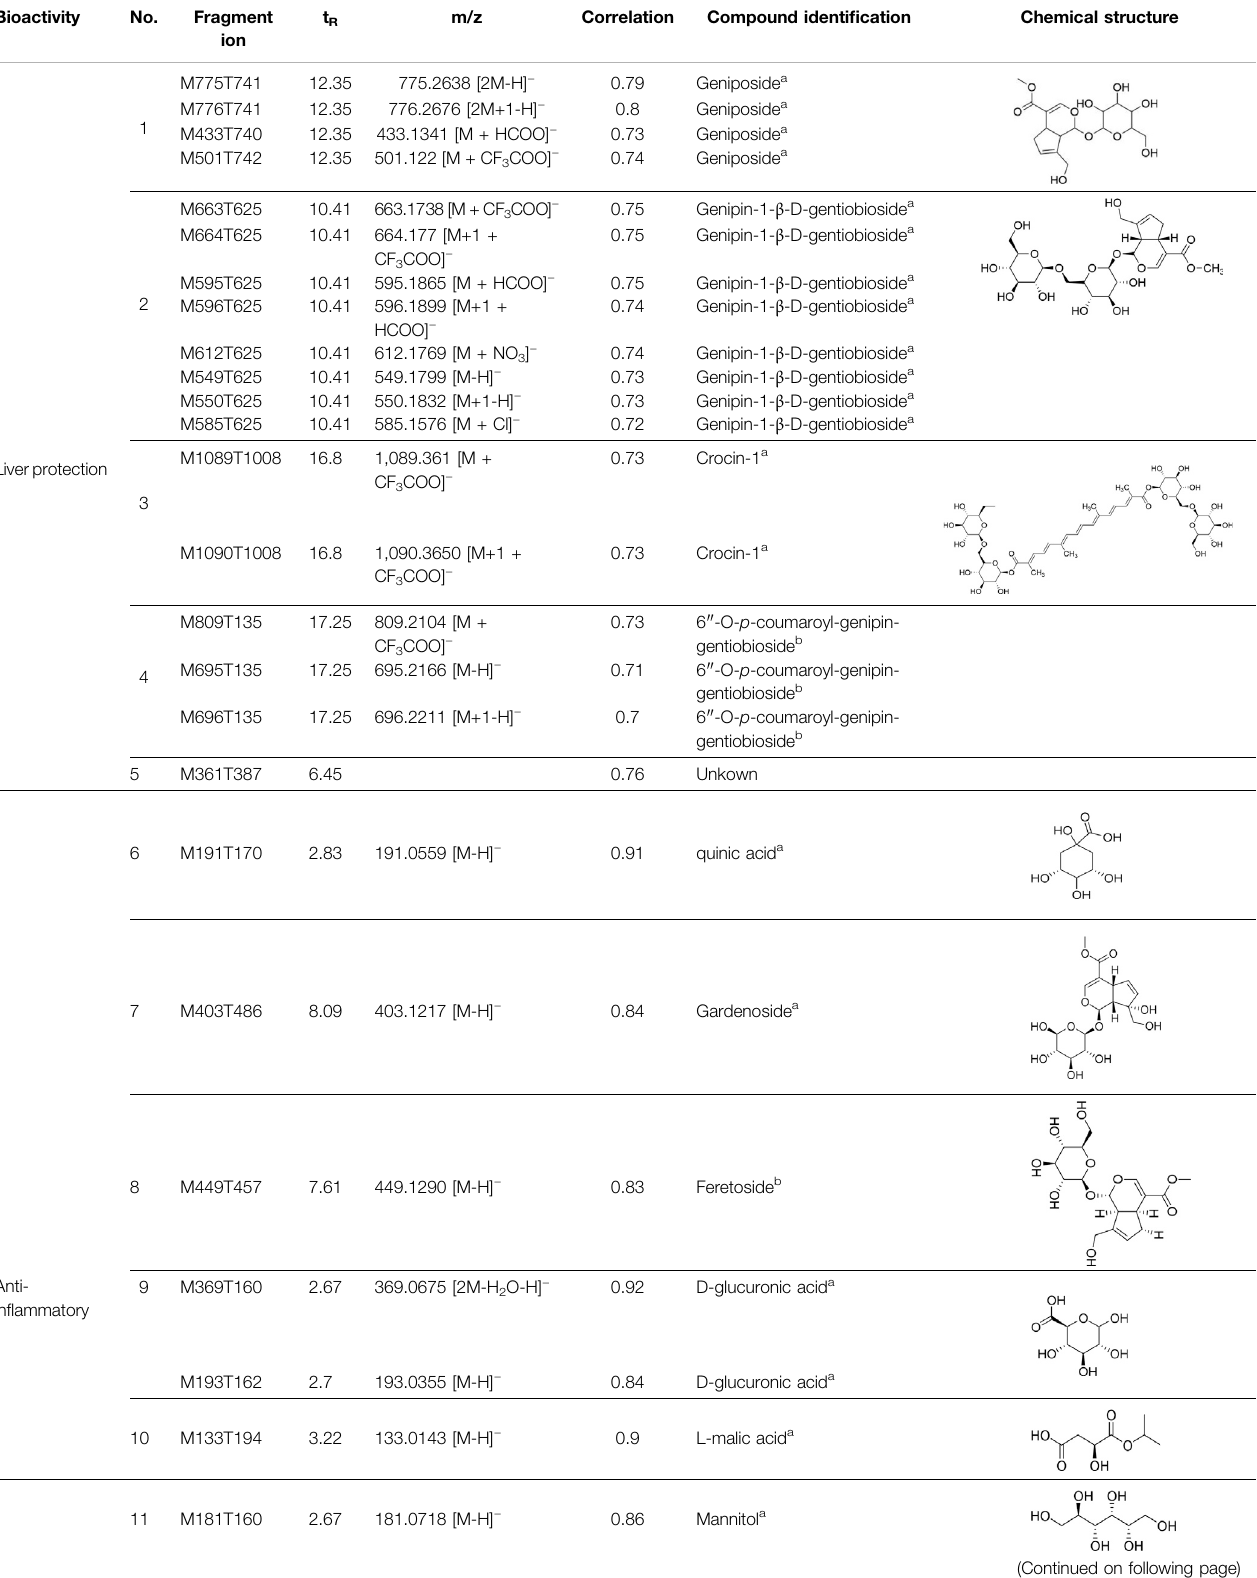
TABLE 3 | Components of liver protection and anti-in fl ammatory effects of GF with gray relational degree > 0.75 and component information.